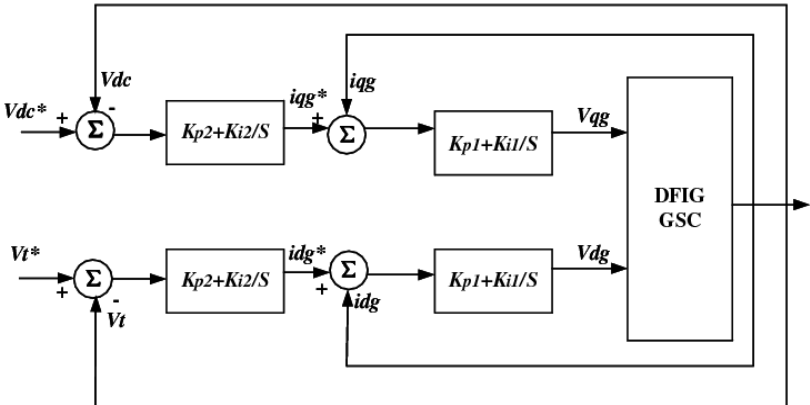
Figure 2. The GSC control scheme in the q-d reference